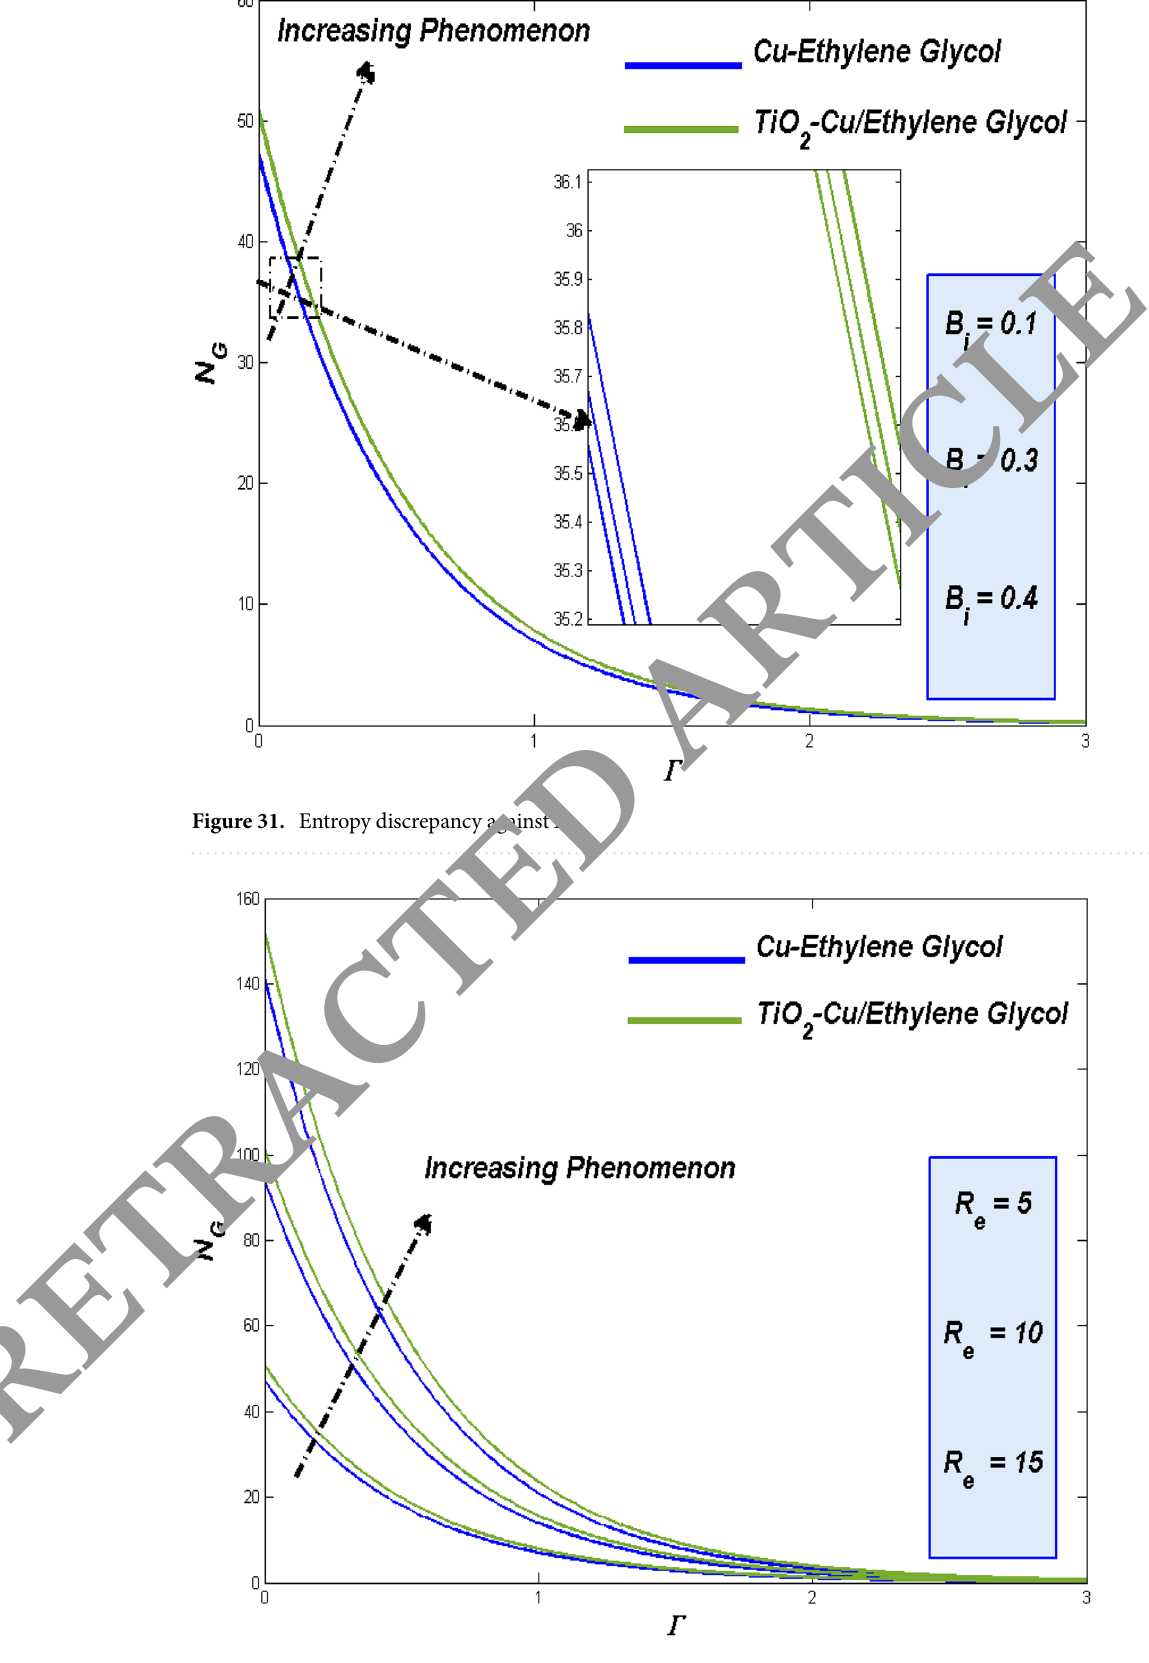
Figure 32. Entropy discrepancy against R e